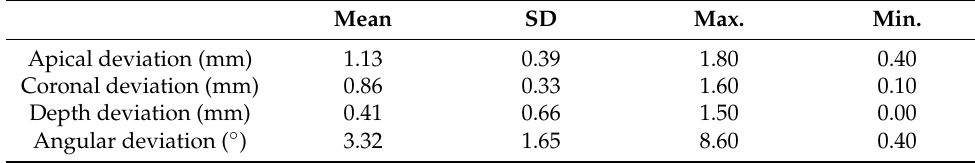
Table 3. Accuracy: deviation